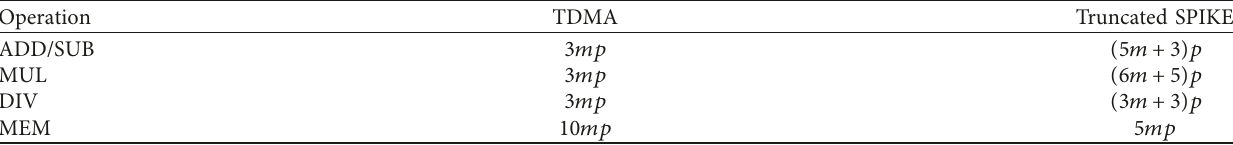
Table 1: FLOP and global memory transactions required for the TDMA and truncated SPIKE FPGA kernels. Operation